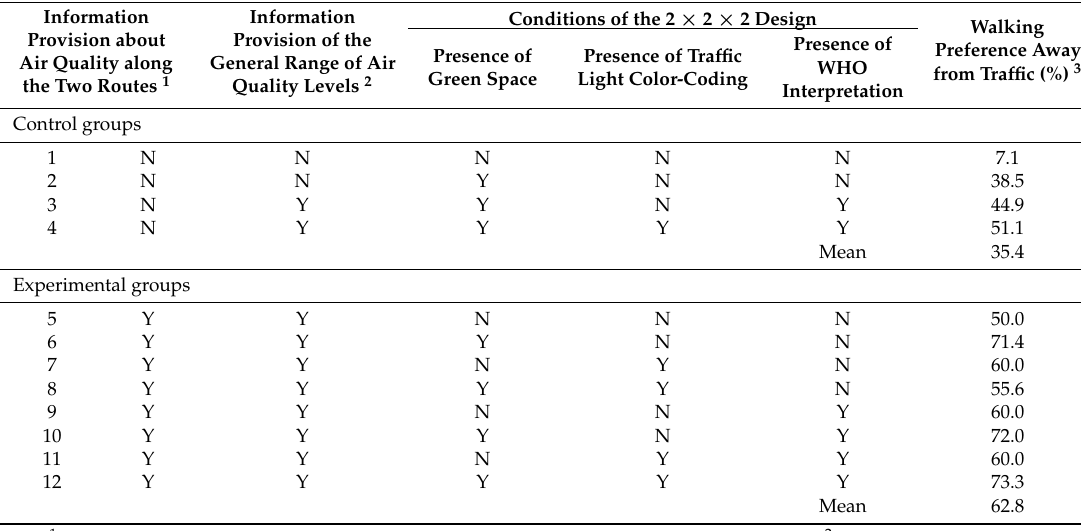
Table 1. Walking preferences along roads away from traffic depending on the experimental manipulations of information that was provided to the participants on a